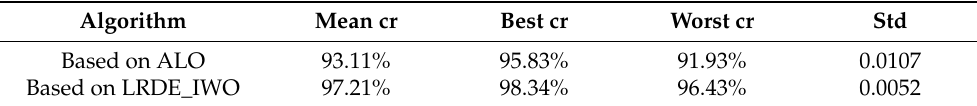
Table 5. Comparison of the optimized coverage results between ALO and LRDE_IWO.